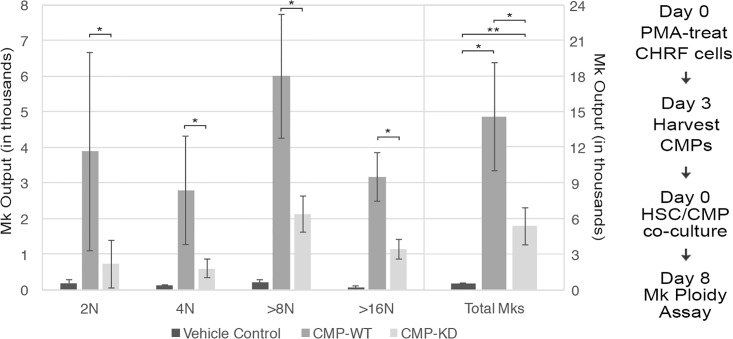
CHRF-derived MPs (CMPs) from p53-KD CHRF cells induce megakaryocytic differentiation of HSCs to a lesser extent than CMPs from wild-type CHRF cells.Number of Mks in each ploidy class and overall (as labeled) following and 8-day co-culture of CD34+ HSCs with vehicle control (black) or CMPs from wild-type (dark gray) or p53-KD (light gray) CHRF cells; Unpaired t-test, *p > 0.05, **p > 0.01, n = 4 (biological replicates).